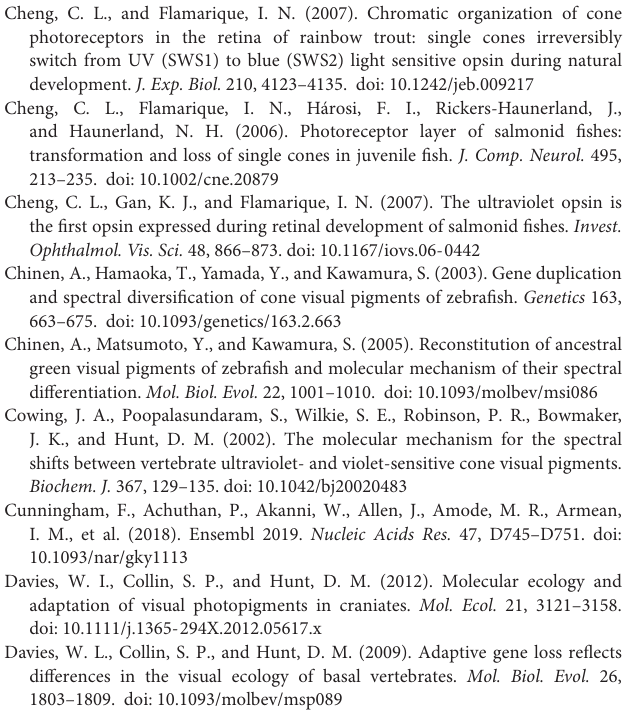
Supplementary Figure 1 | Amino acid alignment of Rh1-1. Supplementary Figure 2 | Amino acid alignment of Sws1-1 and Sws1-2. Supplementary Figure 3 | Amino acid alignment of Sws2. Supplementary Figure 4 | Amino acid alignment of Rh2-1, Rh2-2, Rh2-3, and Rh2-4. Supplementary Figure 5 | Amino acid alignment of Lws1, Lws2, Lws3, and Lws4. Supplementary Figure 6 | Nucleotide alignment of rh1-2.1 and rh1-2.2. Supplementary Figure 7 | Nucleotide alignment of sws1-2. Supplementary Figure 8 | Extended images of visual opsin expression in the developing Atlantic salmon eye. (A1–E1) Visual opsins after hatching (555 dd) and (A2–E2) before first feeding (720 dd). Scale bar 200 µ m. Supplementary Table 1 | Primers used for molecular cloning of visual opsins in Atlantic salmon. Supplementary Table 2 | IDs and chromosome location of visual opsins in salmonids and northern pike. Supplementary Table 3 | Individual normalized count showing the expression of visual opsins in Atlantic salmon during